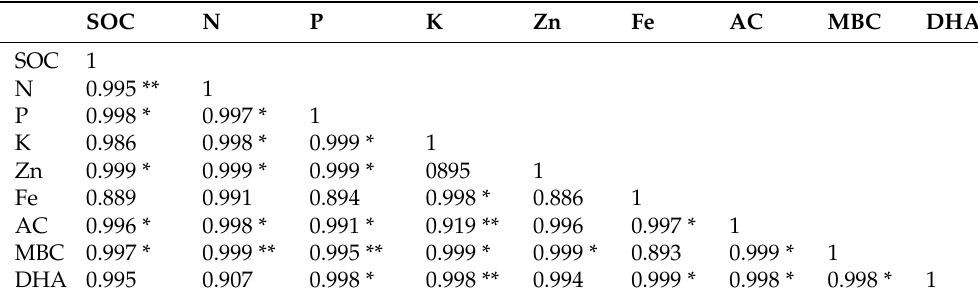
Table 4. Correlation between SOC and other soil chemical and biological